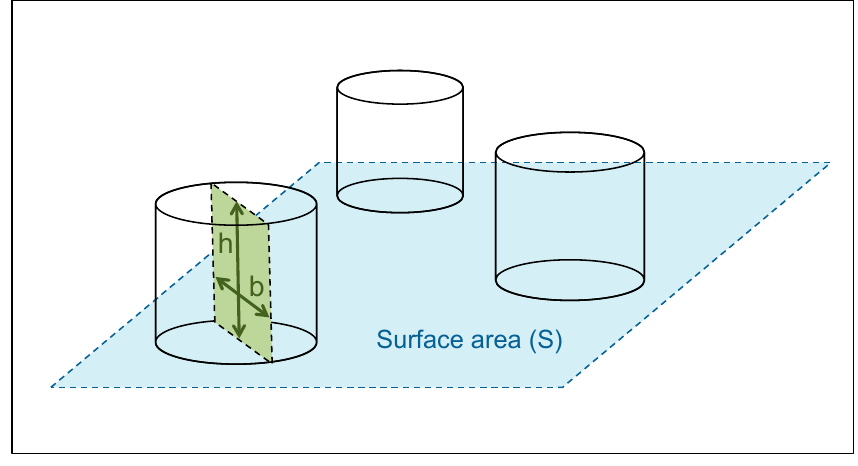
Figure 5. Illustration of the parameters used to calculate roughness density ( λ ) in roughness studies: h is element height, b is element base/width, n is the number of elements, and S is the surface area over which the calculation is made.